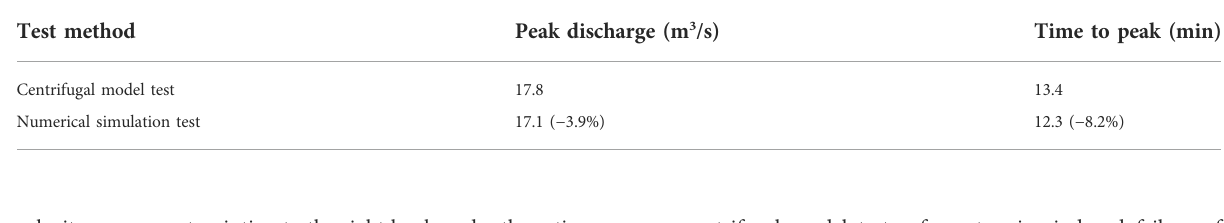
TABLE 5 Comparison of breach parameters (prototype